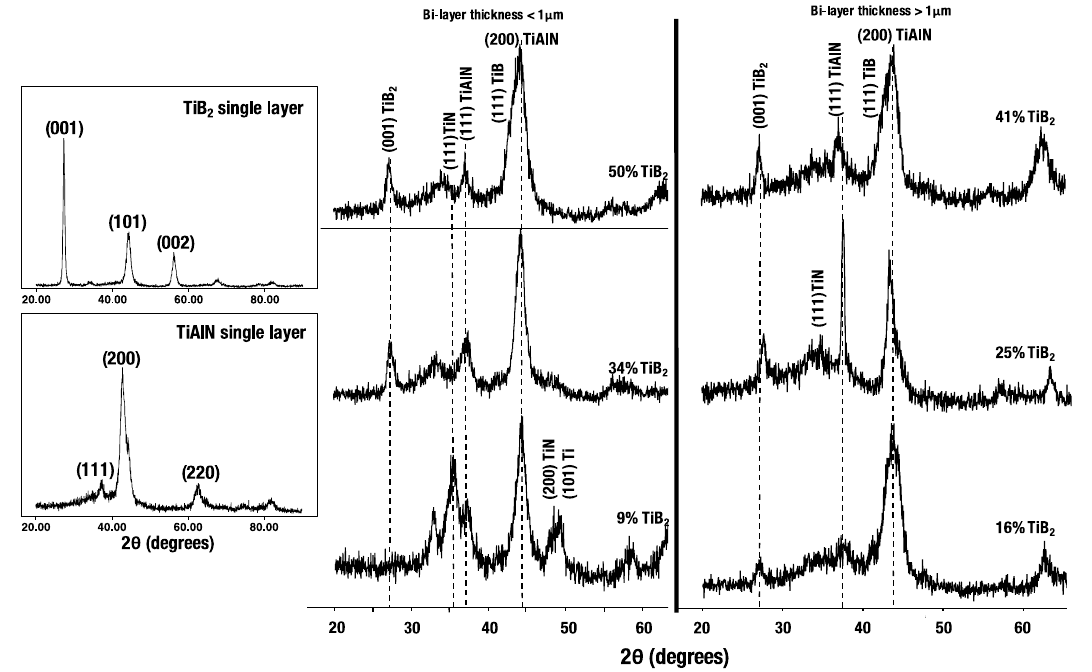
Figure 1. XRD θ –2 θ diffractograms of TiAlN ‐ TiB 2 multilayer coatings with different TiB 2 contents.